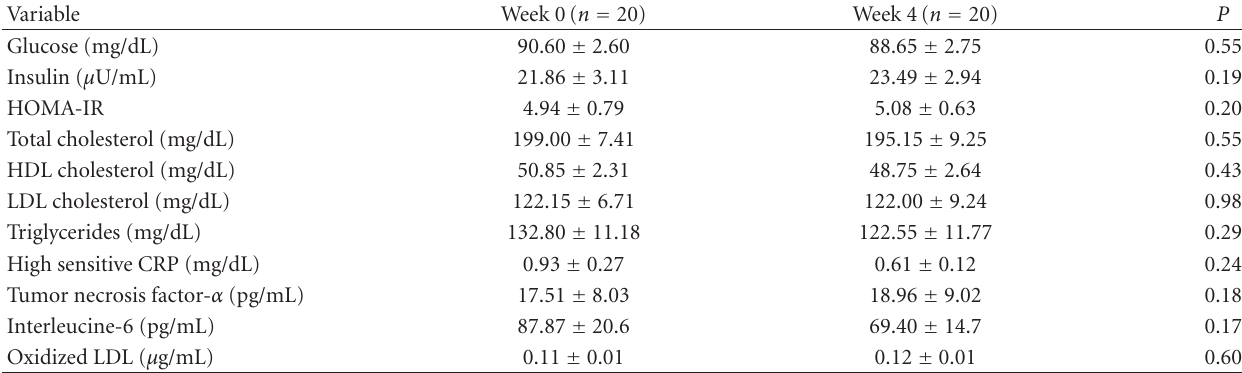
Table 3: Metabolic variables and biomarkers of inflammation and oxidative stress at baseline (week 0) and at the end of the study (week 4). Variable